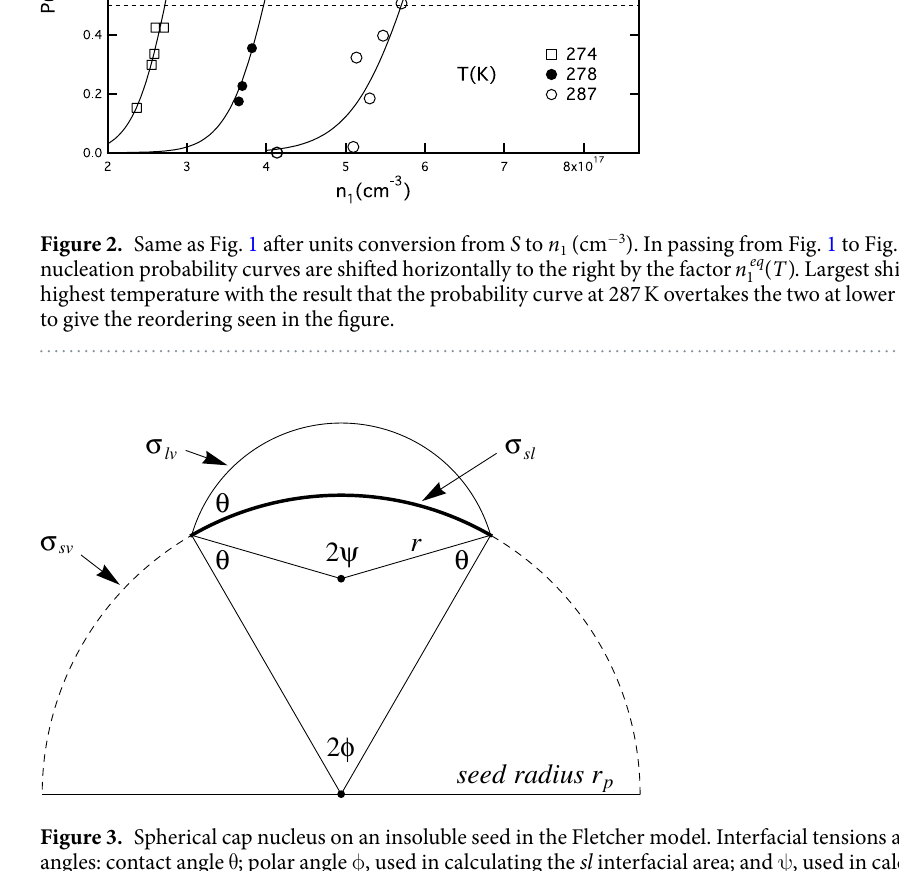
Figure 3. Spherical cap nucleus on an insoluble seed in the Fletcher model. Interfacial tensions and important angles: contact angle θ ; polar angle φ , used in calculating the sl interfacial area; and ψ , used in calculating lv interfacial area, are indicated in the figure. The upper and lower points mark the centers of curvature of the spherical cap and the seed,